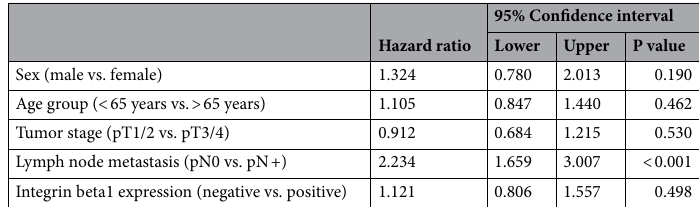
Table 3. Multivariate cox-regression analysis for patients after neoadjuvant (chemo) radiotherapy.